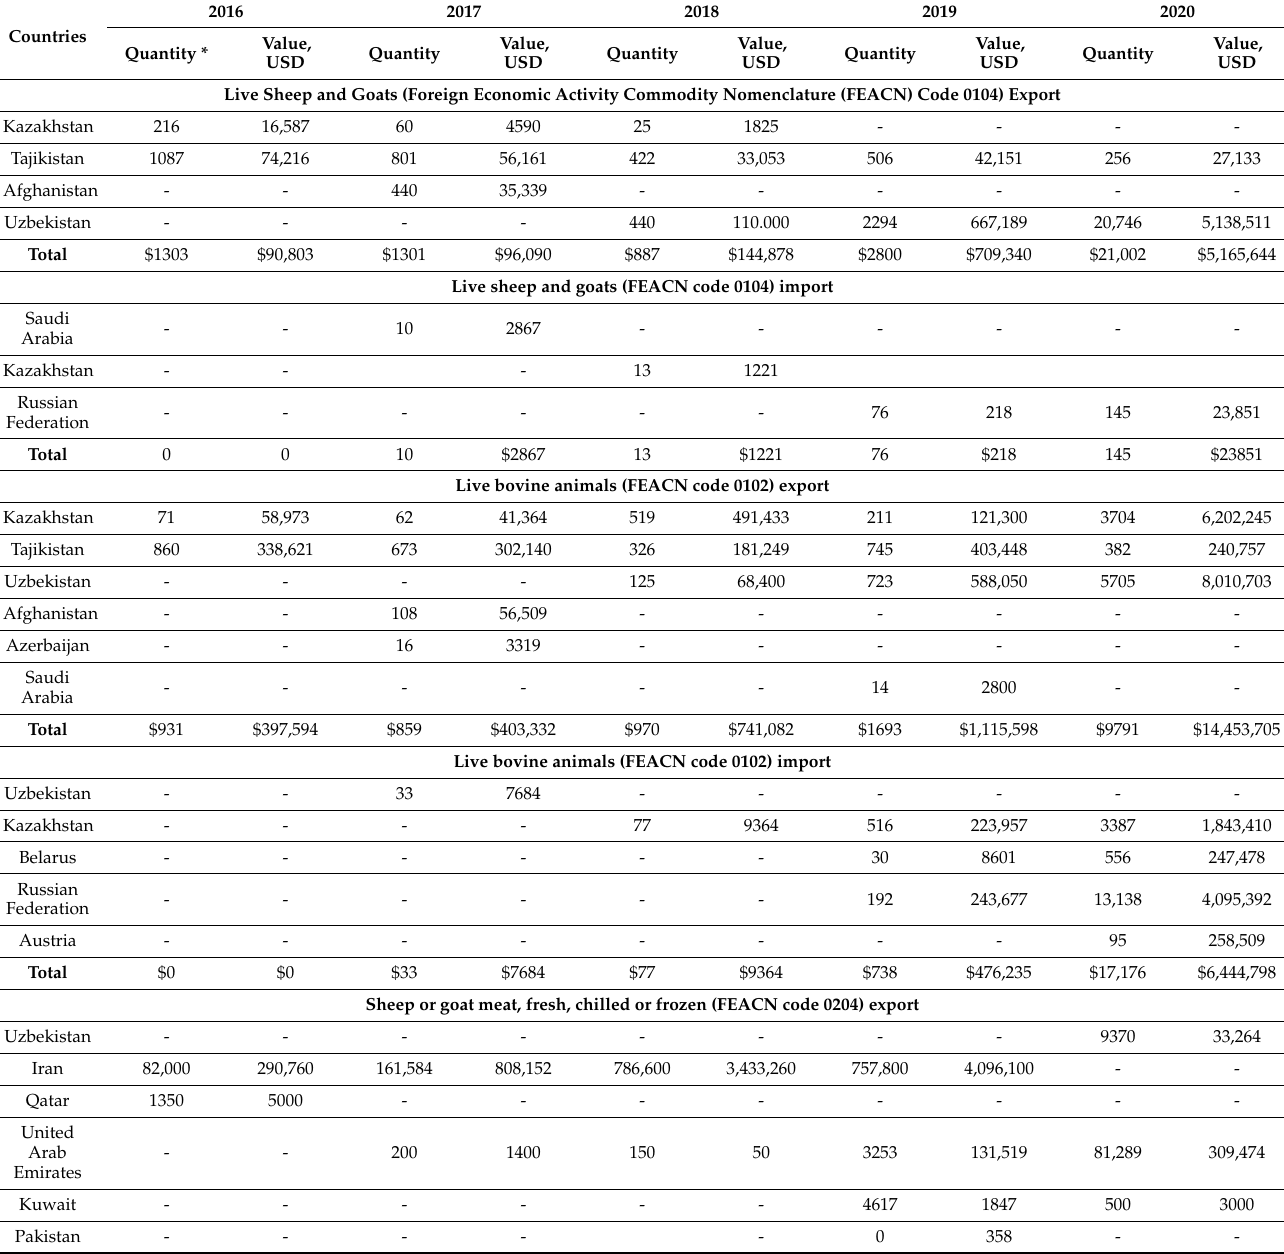
Table 2. Export and import of animals and meat from/to Kyrgyzstan from 2016 to 2020 (Quantity * in thousands of heads animals and tons of meat). Adapted from www.comtrade.un.org, accessed on 3 January 2022